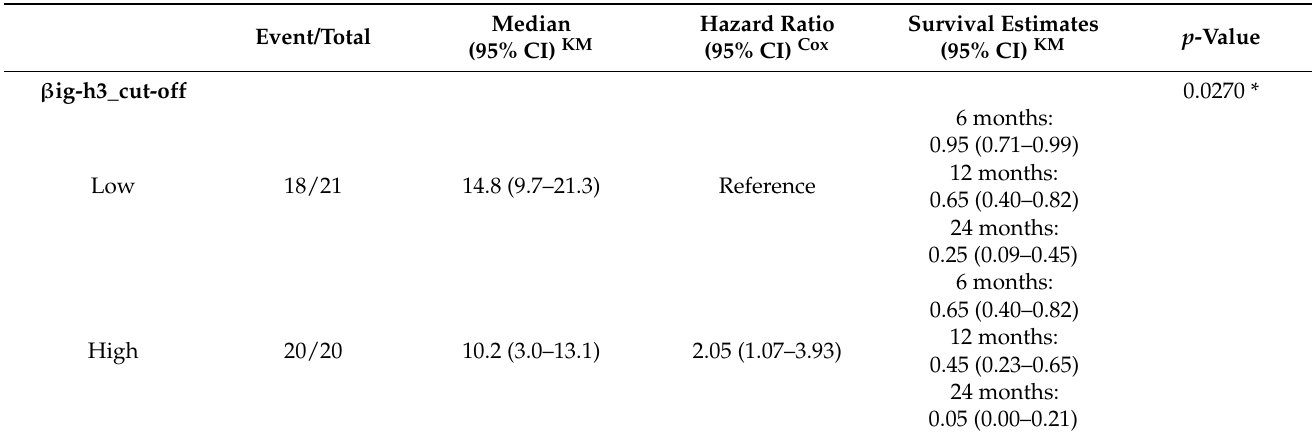
Table 2. Analysis for overall survival.